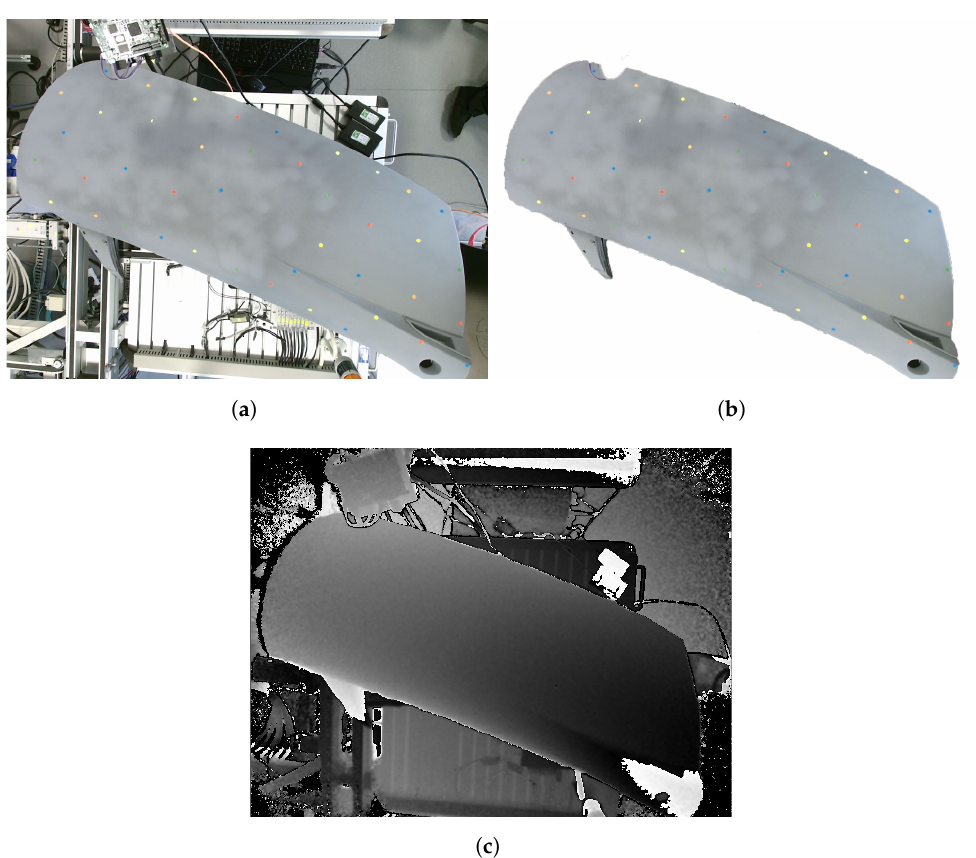
Figure 6. Image of 3D printed car door captured under different camera resolution, i.e., 1392 × 1040, 1044 × 780, and 696 × 520. ( a ) Original image, ( b ) Manually extracted image, ( c ) Respective depth image.